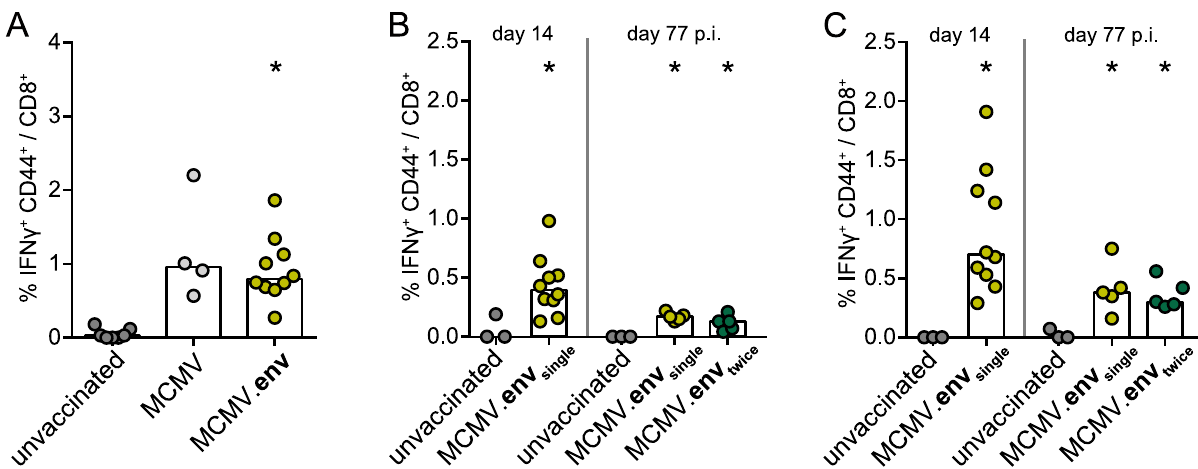
Fig 2. MCMV-specific CD8 + T cell response. CB6F1 mice were infected once or twice in a three-week interval with 2 × 10 5 PFU of the indicated MCMV-based vectors. (A) Two weeks after a single immunization, the MCMV-specific CD8 + T cell response was analysed after restimulation with a pool of five MCMV-derived peptides. (B, C) Two weeks or 11 weeks after the first immunization, the MCMV-specific CD8 + T cell response was analysed after restimulation with a pool of four peptides representing the conventional MCMV-epitopes M45 985-993 , M57 816-824 , M102 446-455 and m141 15-23 (B) or with a peptide representing the inflationary MCMV epitope m139 419-426 (C). Data were acquired in two (A) or one experiments (B, C), each dot represents one mouse, bars indicate mean values. Statistically significant differences compared to unvaccinated mice are indicated by � ( P < 0.05; One Way ANOVA, Holm-Sidak post test).